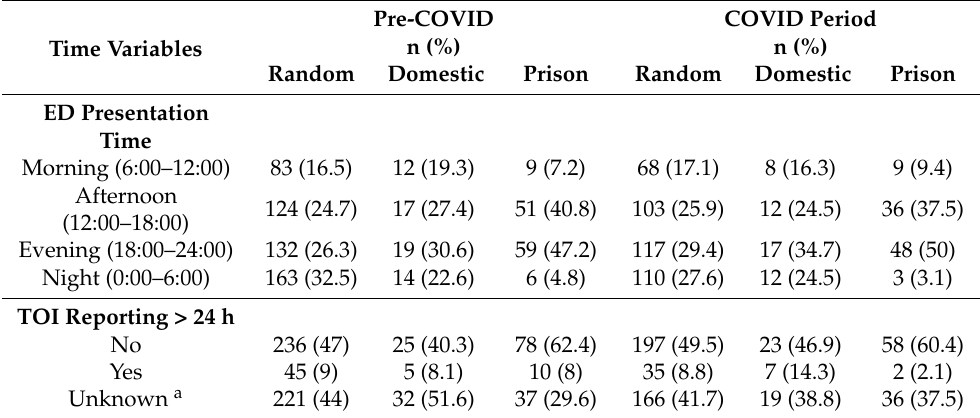
Percentages are based on Australian group rather than assault subgroup totals. c ‘Unknown’